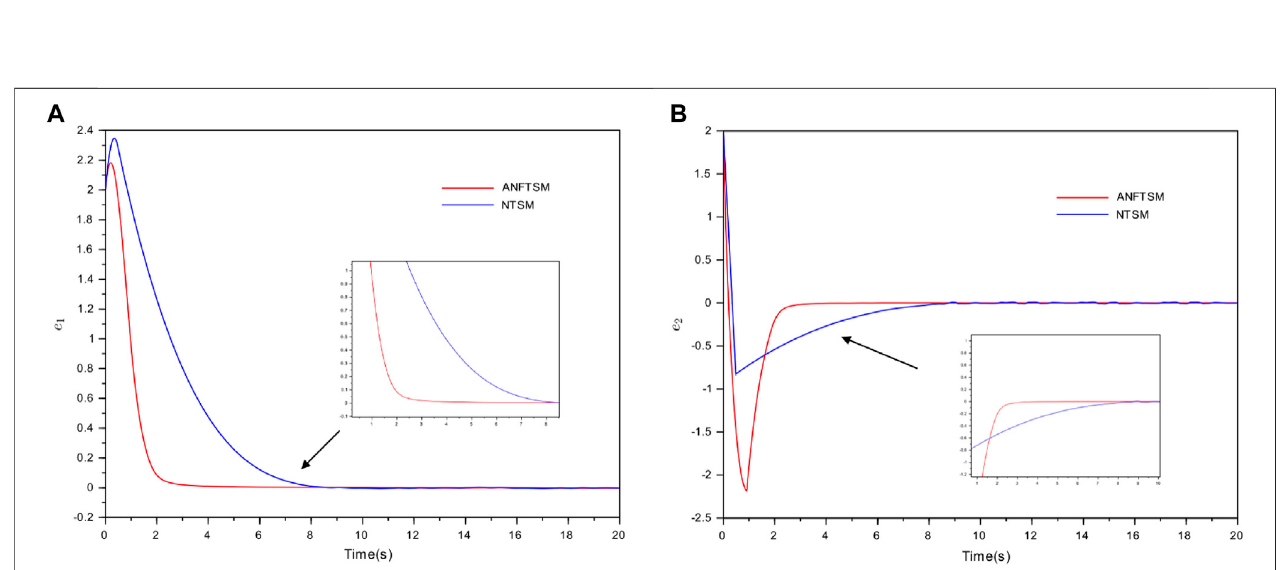
FIGURE4| ThecomparisonofsynchronizationerrorsbetweenANFTSMandNTSMofExample 1 (A) thesynchronizationerror e 1 (B) thesynchronization error e 2 .